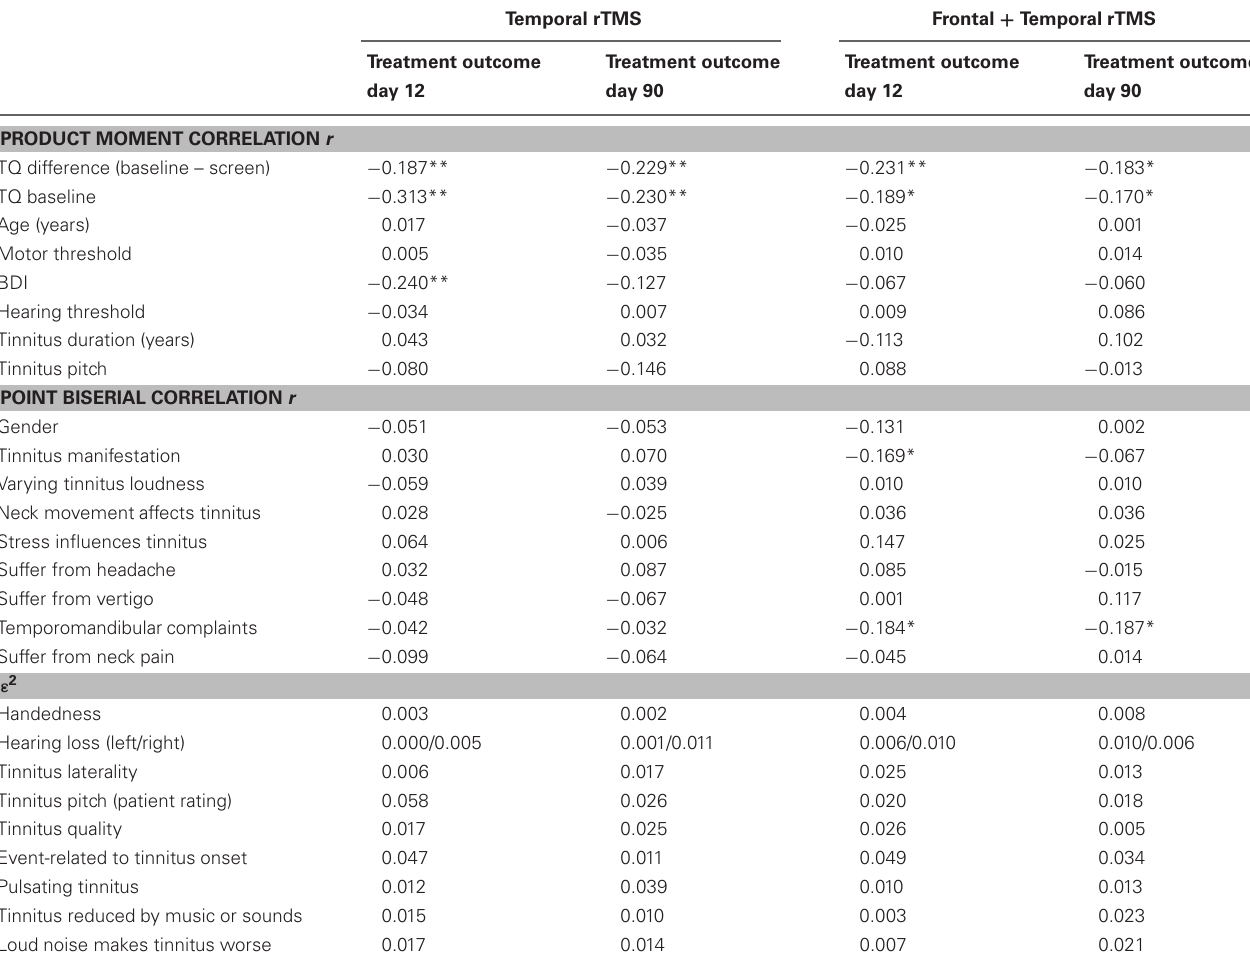
Table 2 | Correlations between treatment outcome and predictors for both treatment groups. Temporal rTMS Frontal + Temporal rTMS Treatment outcome Treatment